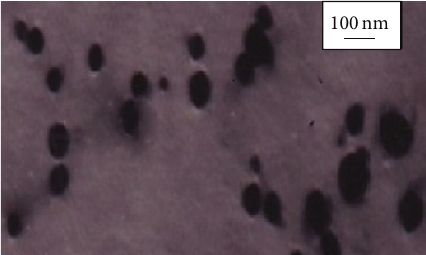
Figure 5: Ag NPs synthesized using Leptadenia reticulata extract [47] (reproduced with permission from